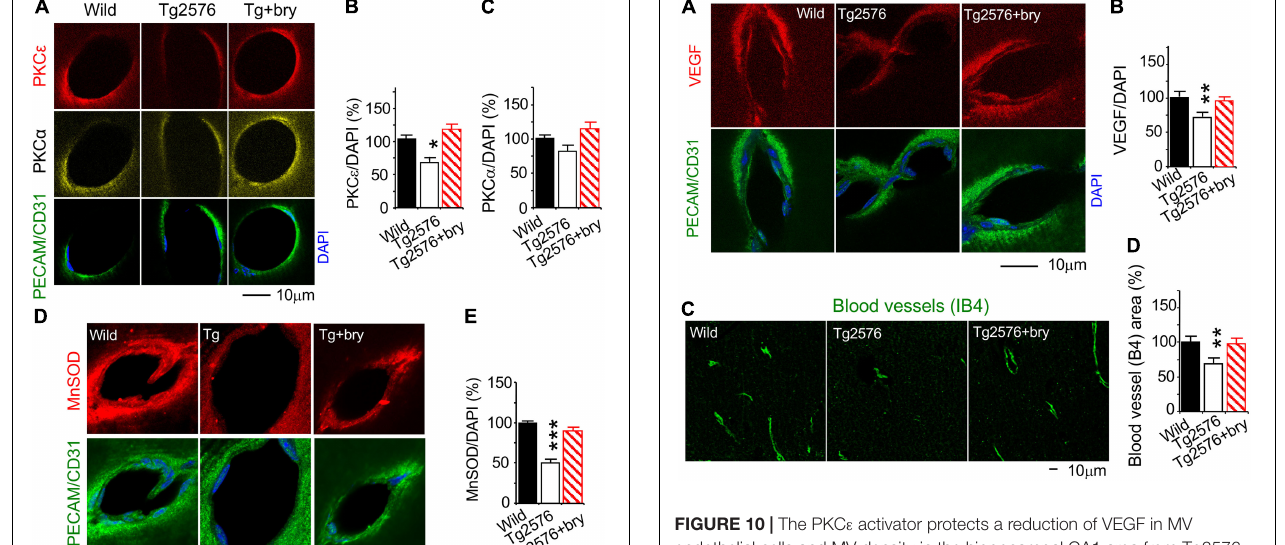
FIGURE 10 | The PKC ε activator protects a reduction of VEGF in MV endothelial cells and MV density in the hippocampal CA1 area from Tg2576 transgenic AD mice. Tissue sections from animals in Figure 9 were used. (A) Double immunohistochemistry and confocal microscopy of (B) VEGF in vascular endothelial cells that were marked with PECAM/CD31. (C) Cytochemistry of the vascular endothelial cells marker IB4, imaged with a confocal microscope, was used to determine (D) MV density in random CA1 areas. Bryostatin (bry) prevented the loss of VEGF and MV density in Tg2576 (Tg) mice. Data are represented as mean ± SEM, ** p < 0.01; one-way ANOVA and post hoc Tukey’s multiple comparison test. ( n = 35–74 random MV cells or 19–28 random areas from 3 to 5